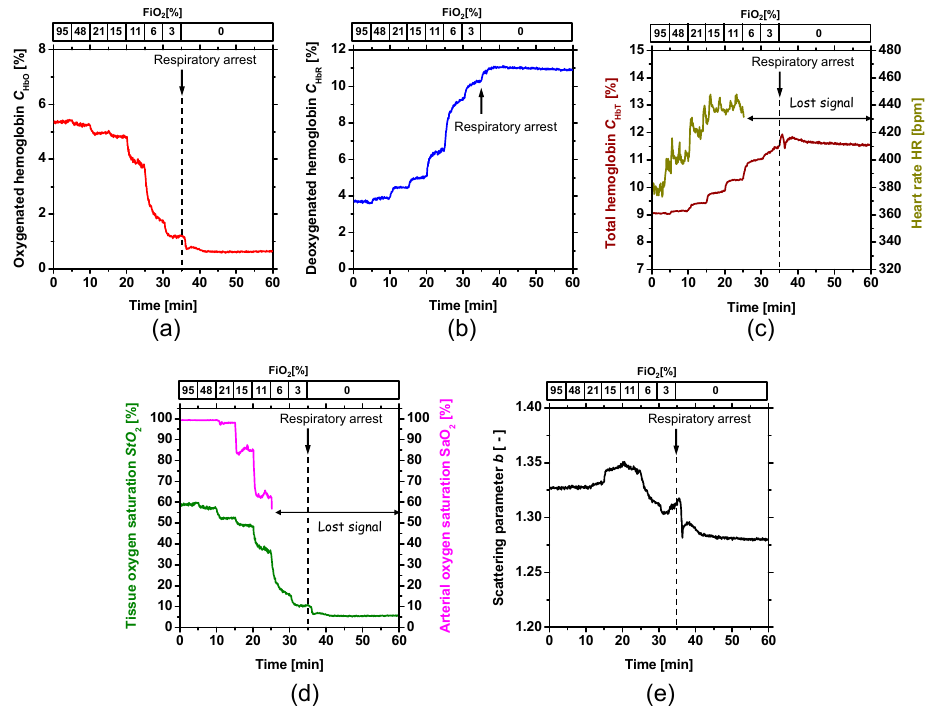
Figure 2. Typical time courses of ( a ) oxygenated hemoglobin C HbO , ( b ) deoxygenated hemoglobin C HbR , ( c ) total hemoglobin C HbT and heart rate HR, ( d ) hemoglobin oxygen saturation StO 2 and ( e ) arterial oxygen saturation SaO 2 , and scattering power b averaged over the area for the region of interest (ROI) on the parenchymal region.